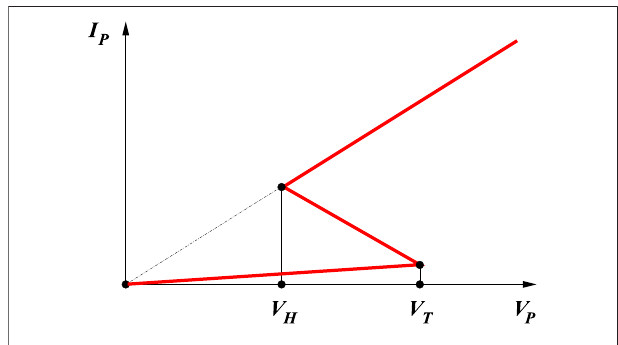
FIGURE 2 | Schematic model of the S-shaped I P ( V P ) characteristic of the